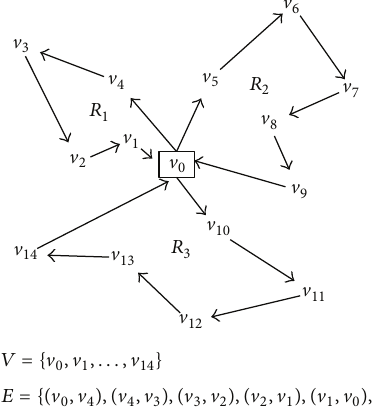
Figure 1: A graphical representation of an example of the